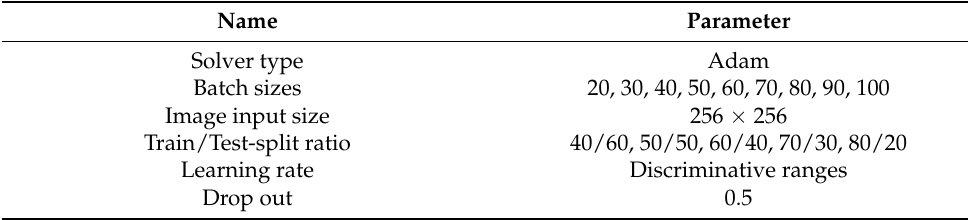
Table 13. Configuration of the machine